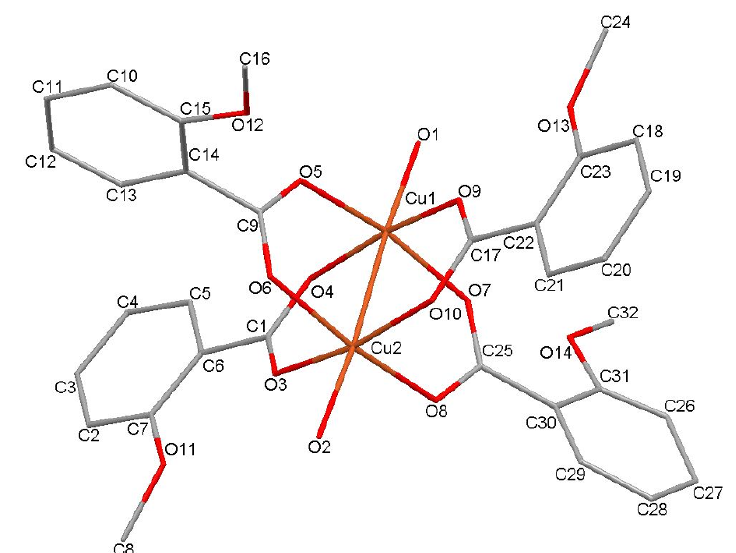
Figure 3. Crystal structure of bis(aqua-bis(μ